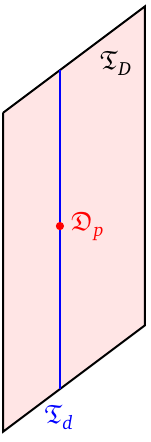
Figure 7: A sub-defect D